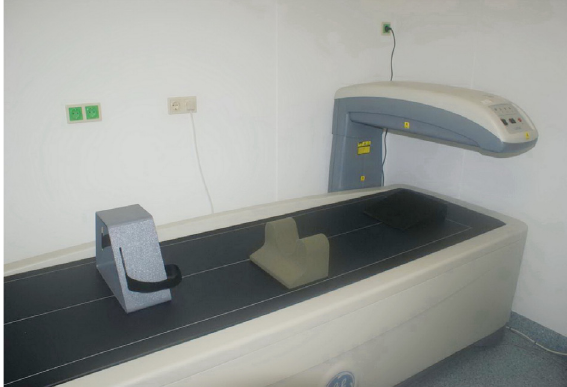
Figure 3. DEXA scan with the appropriate positioning aids.